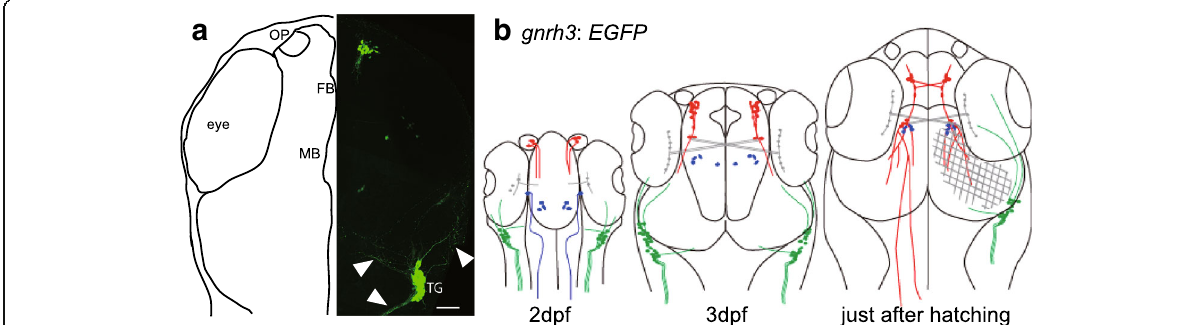
Fig. 4 Morphology of GnRH-expressing trigeminal nerve neurons ( a ) gnrh3 :e gfp neuron in medaka at 2.5 dpf. EGFP-expressing trigeminal nerves have both rostral and caudal projections (arrowhead). OP: olfactory placode, FB: forebrain, MB: midbrain, TG: trigeminal ganglion. ( b ) A schematic illustration of the projections of gnrh3 :e gfp neurons at different developmental stages. Red, GnRH3 neurons in the terminal nerve and the thalamus originating from the olfactory placode, migrating to the brain, and projecting broadly in the brain. Blue, GnRH3 neurons in the thalamus originating from the brain. Because GnRH neurons in the thalamus contain only a few neurons, we did not discuss them in this review (see Takahashi et al., 2015 [9]). Green, GnRH3 neurons in the trigeminal ganglion, Gray, retinal neurons expressing EGFP ectopically. Because these ectopic retinal fiber projections and trigeminal ganglion fibers interfere with the illustration of GnRH3 neuron projections (red), we only indicated these fibers (gray and green) in the right half of the brain. During the late stages of development, red and blue neurons appeared to be intermingled. Both figures were modified from Takahashi et al., 2015